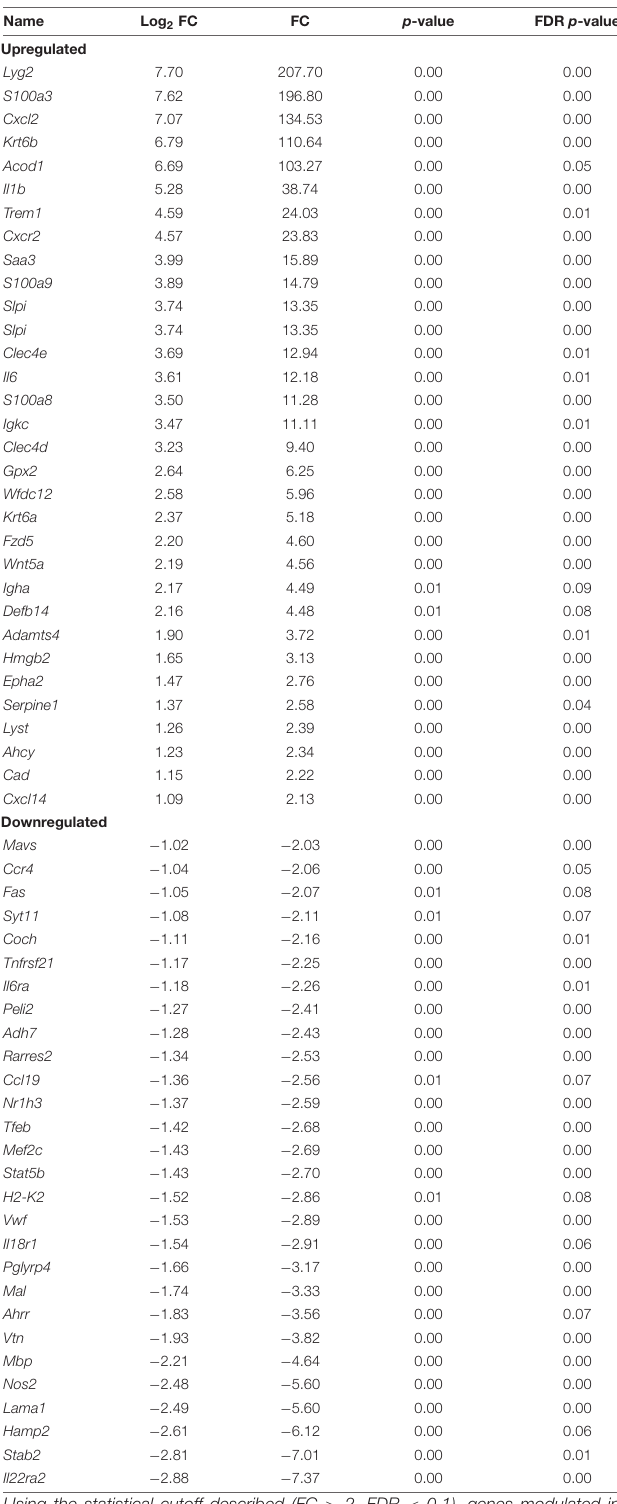
TABLE 4 | Antimicrobial associated genes differentially modulated in IL-6-deficient (KO) skin as compared with C57BL/6 skin.